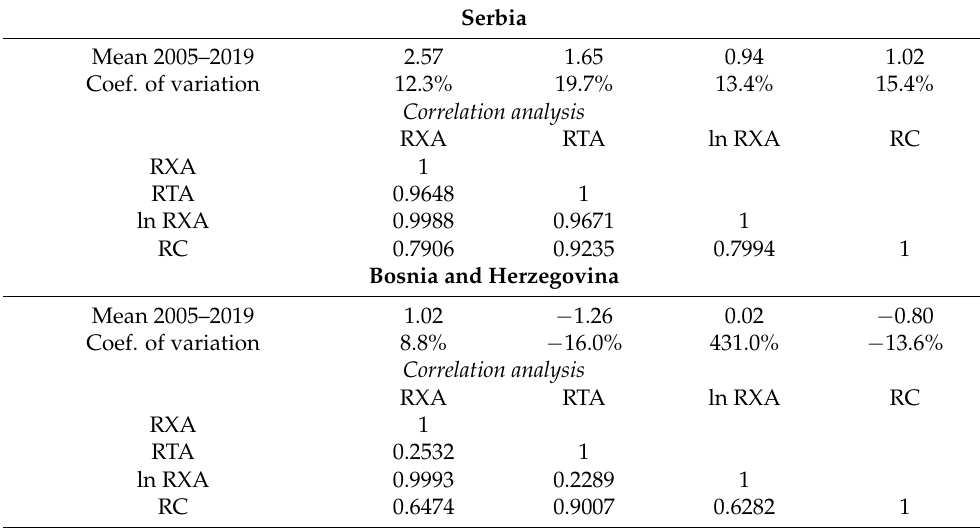
Table 2. Revealed comparative advantages of agri-food sector of the WB countries calculated by different indicators.